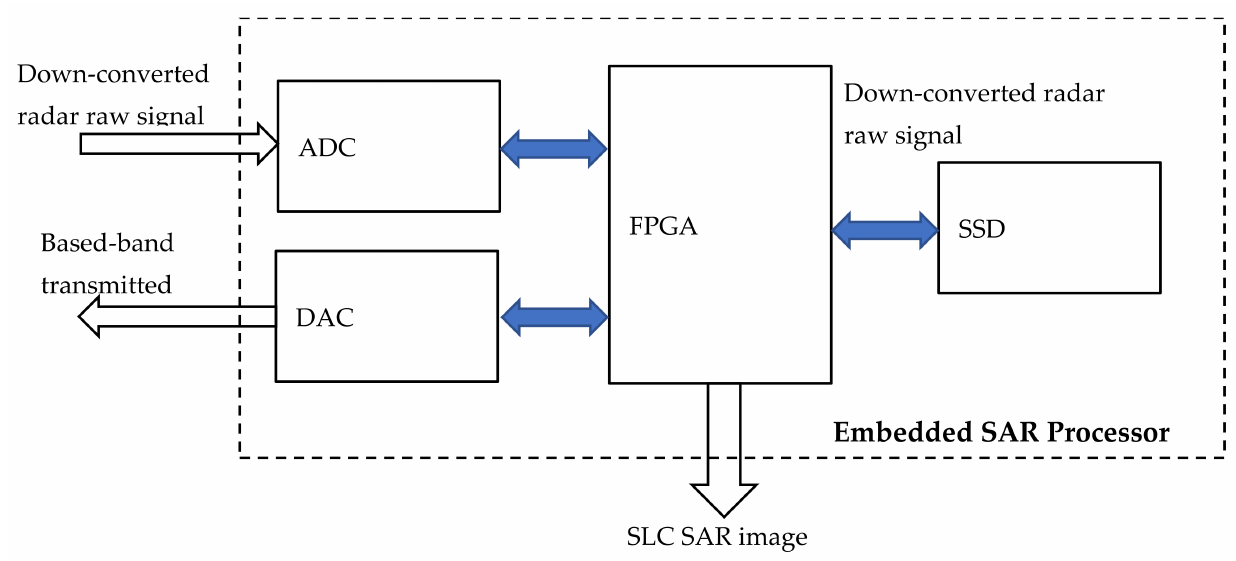
Figure 1. Embedded SAR processor block